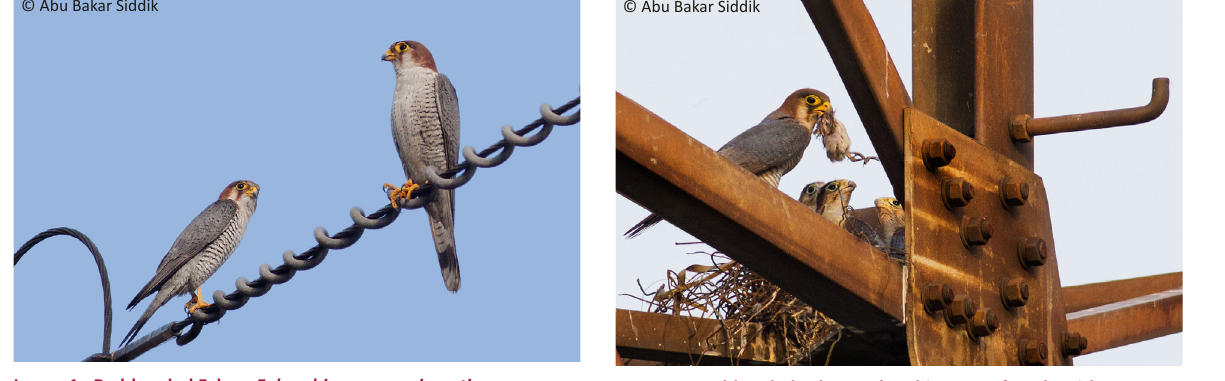
Image 2. Red-headed Falcon Falco chicquera - female with prey with